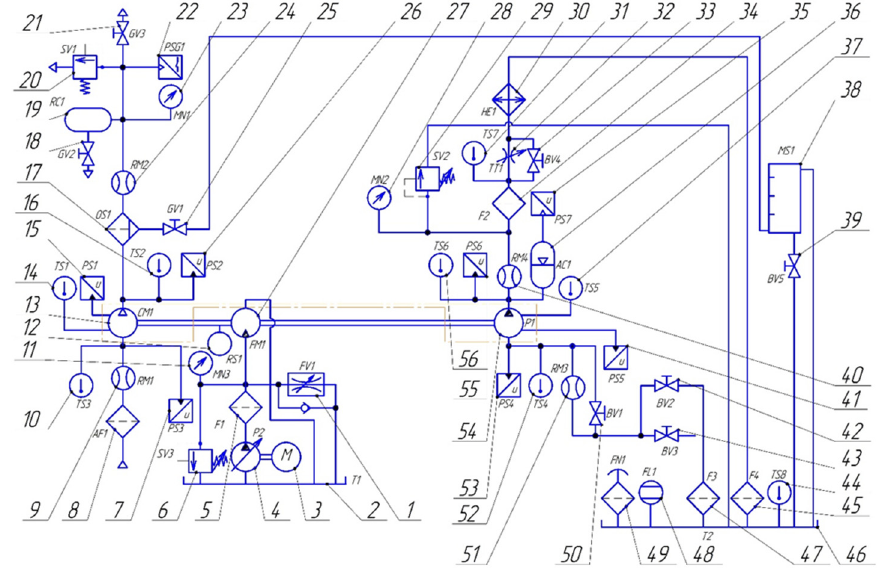
Figure 8. Hydro pneumatic diagram of the test bench to study a crosshead-free PHPM. Legend: